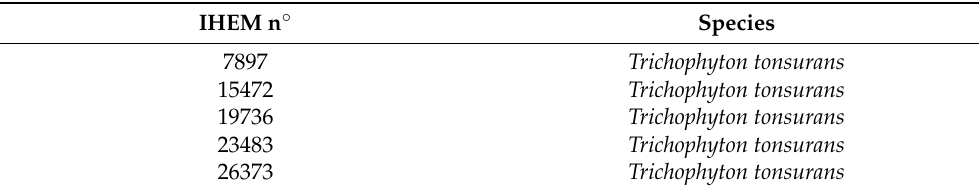
Table 6. Reference strains employed to set up a database based on liquid cultures, originating from the BCCM/IHEM fungal